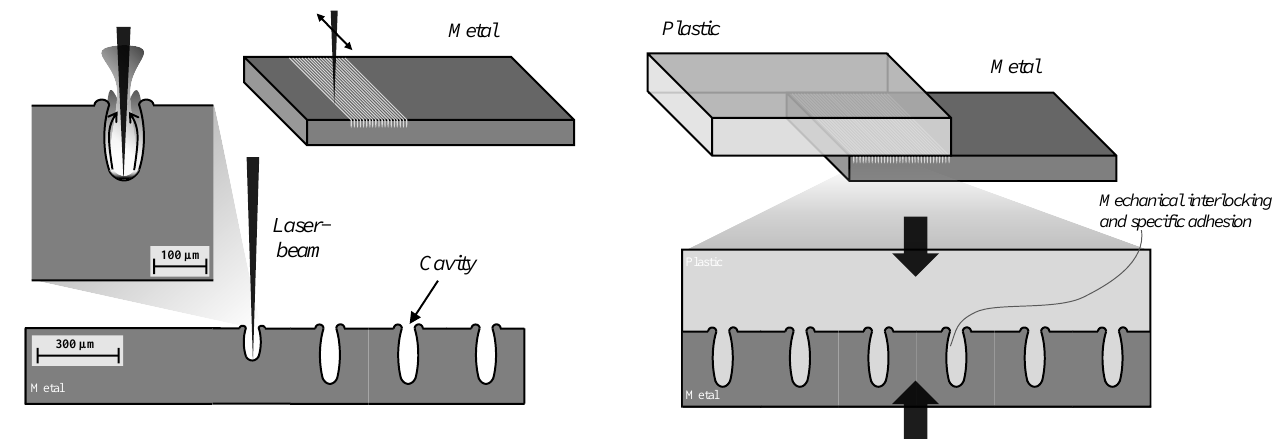
Figure 1. Laser-based joining process of plastics and metals.